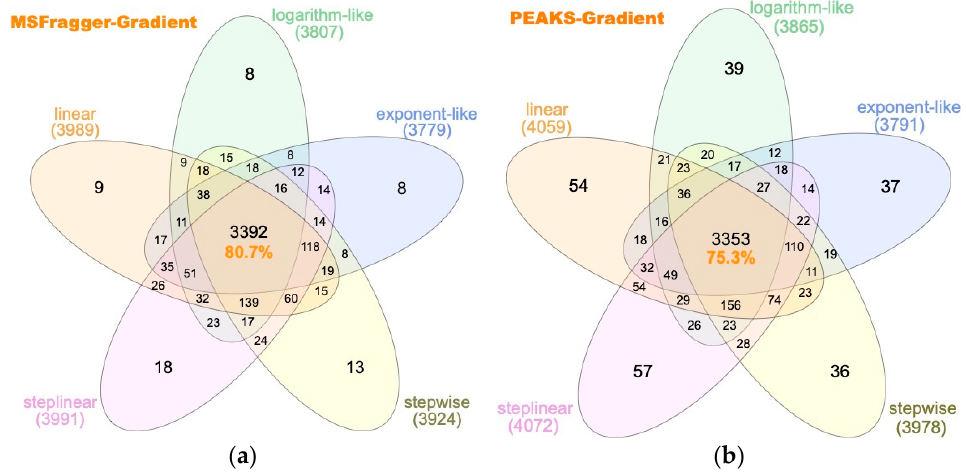
Figure 7. Comparison by gradient types and search engines using a 100 ng HeLa digest on-column loading. ( a ) Venn diagram showing identified protein groups using MSFragger, ( b ) Venn diagram showing identified protein groups using PEAKS Studio.